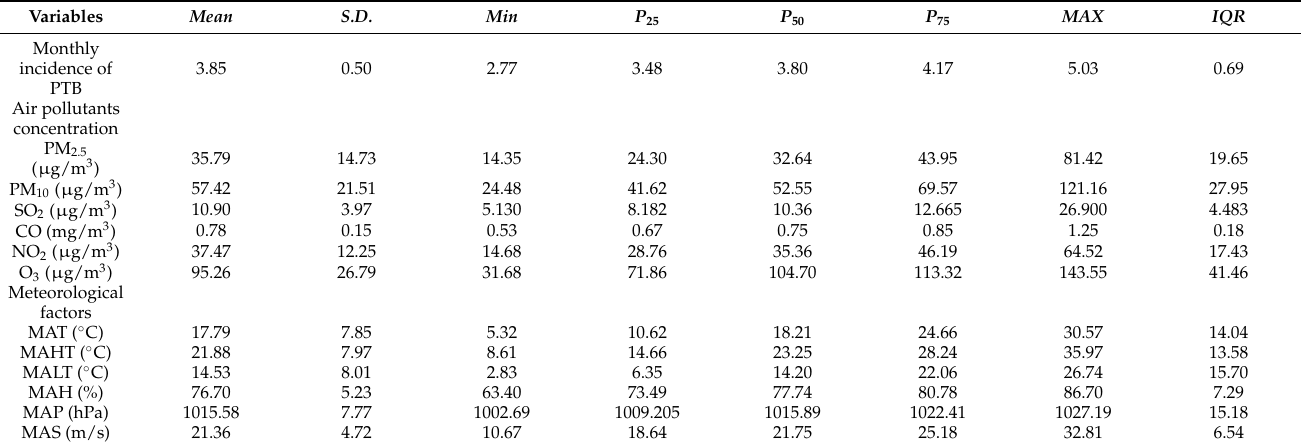
Table 1. Descriptive statistics of the monthly incidence of PTB, the monthly average air pollutants concentration, and meteorological factors in Ningbo from 2015 to